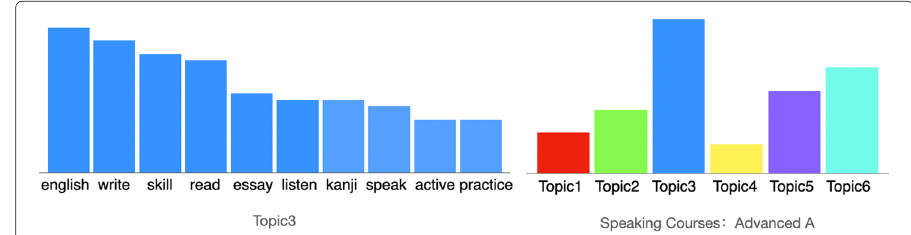
Fig. 3 Keyword distribution in topic3 and topic distribution in the course Speaking Courses: Advanced